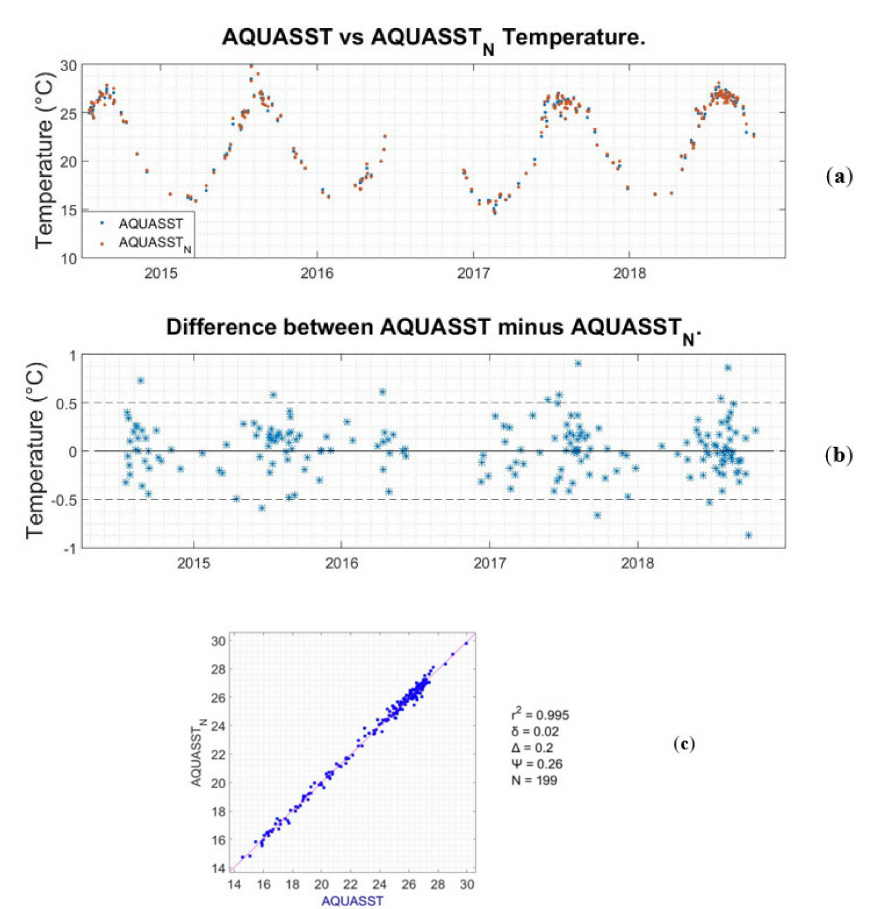
Figure 8. ( a ) AQUASST (in situ logger’s cell) data compared with AQUASST_N (respective northern adjacent cell) data from the same satellite swath. All data have quality flags of 0, 1, and 2. ( b ) Di ff erence between the AQUASST minus the AQUASST_N dataset. ( c ) Correlation plot between the AQUASST and the AQUASST_N dataset (refer to Section 2.4 for